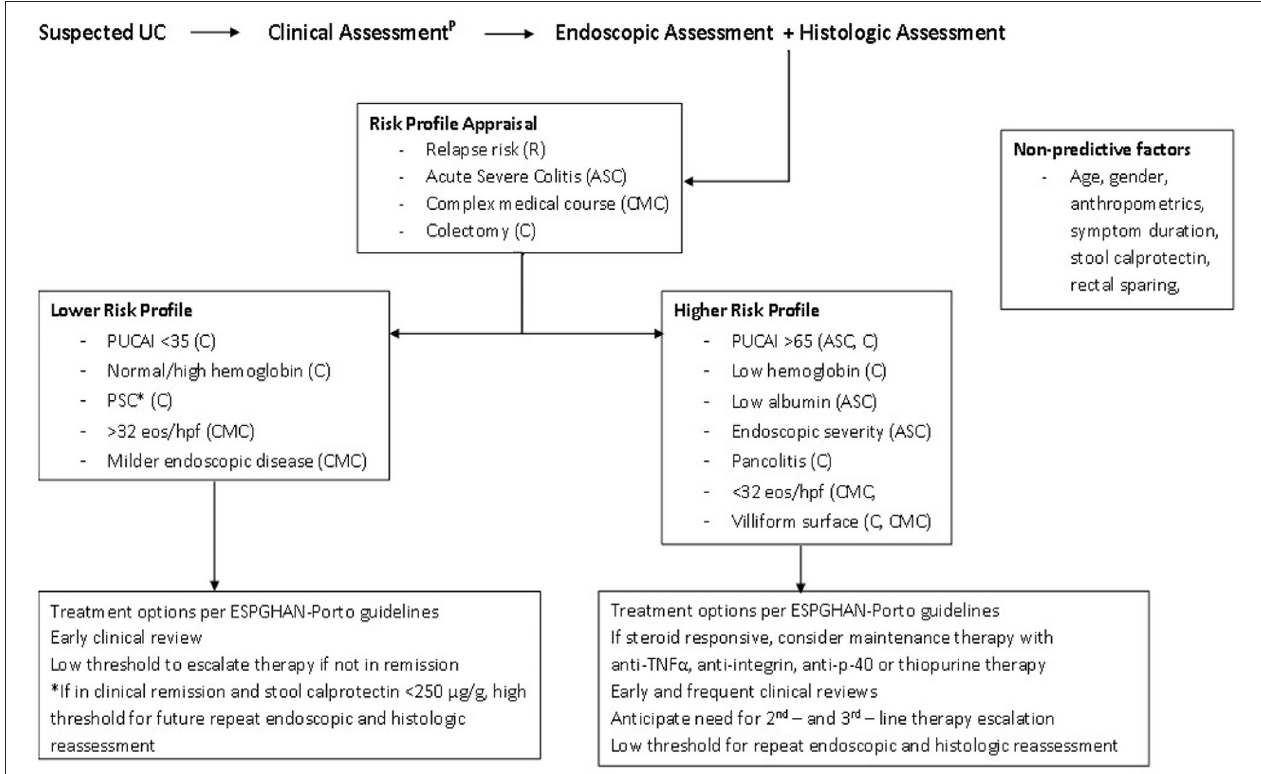
FIGURE 1 | Patient risk profile pathway. *PSC increases the lifetime risk of malignancy. Ongoing endoscopic and histologic disease activity is described in those with PSC-UC, despite reassuring PUCAI scores. Consider more frequent monitoring using calprotectin and/or endoscopy. P According to the IBD Porto guidelines. PUCAI, Pediatric Ulcerative Colitis Activity Index; PSC, Primary Sclerosing Cholangitis; eos/hpf, rectal eosinophils per high powered field; ESPGHAN, European Society for Pediatric Gastroenterology, Hepatology and Nutrition (65,